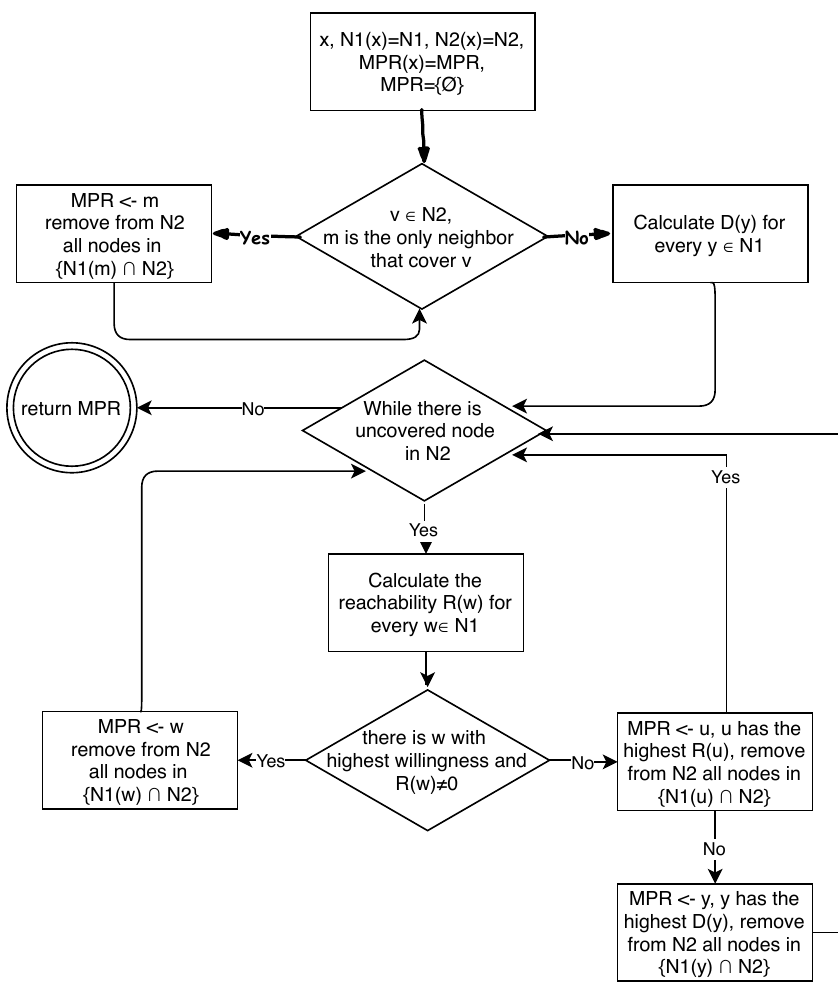
Figure 4. MPR computation function of original